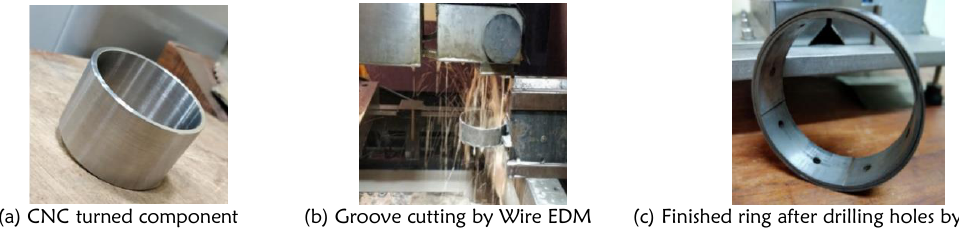
Figure 3: Photographs showing Sequence of operations performed during the fabrication of ISSFD rings